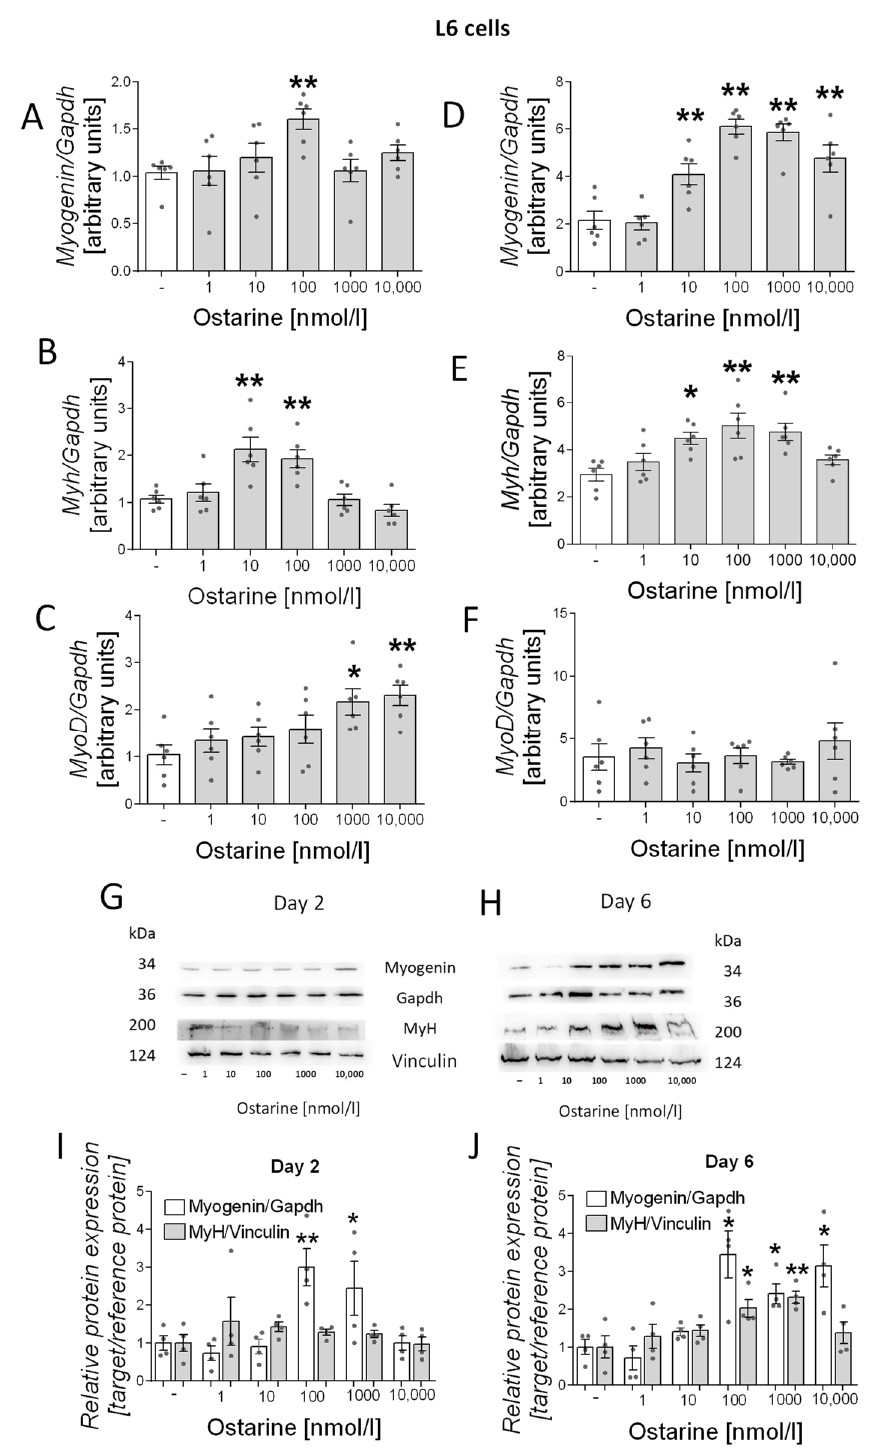
Figure 3. Effect of ostarine on L6 differentiation. mRNA expression of myogenin , myh , and myoD after ( A – C ) 2 days and ( D – F ) 6 days of differentiation initiation. ( G , H ) Effect of ostarine on myogenin and MyH protein level changes after 2 and 6 days of differentiation initiation and quantification of the amount of proteins in day 2 and day 6 ( I , J ). Statistically significant differences are represented as * p < 0.05 and ** p < 0.01 versus corresponding control using one-way ANOVA followed by Dunnett’s post hoc test.